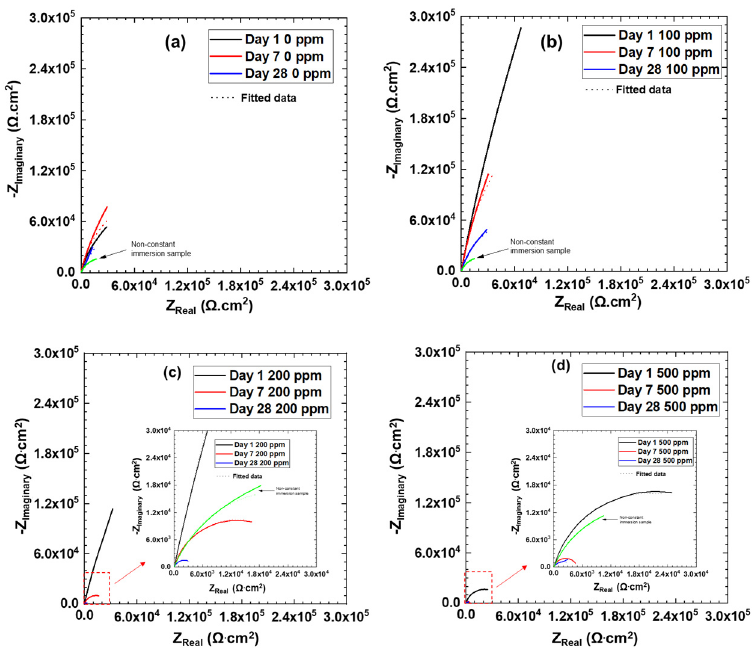
Figure 5. Nyquist plots of cast iron samples after different constant exposure to engine coolant environment containing ( a ) 0 ppm Cl − ( b ) 100 ppm Cl − ( c ) 200 ppm Cl − and ( d ) 500 ppm Cl − . Non-constant immersion sample scan was performed after ~30 min of exposure to respective chloride concentration.